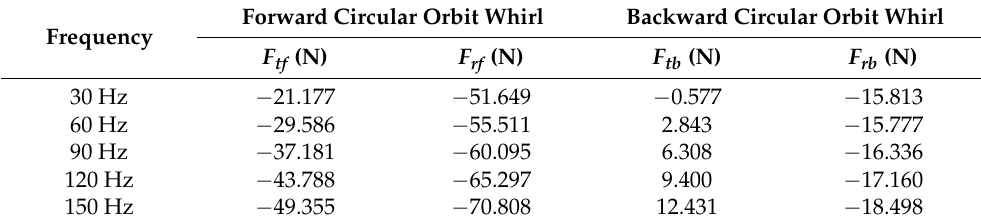
Table 3. Tangential and radial forces of two decomposed circular orbit models.